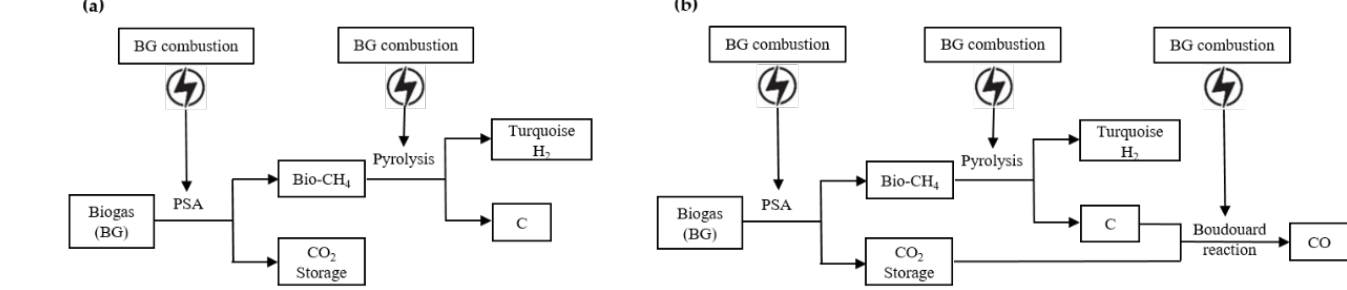
Figure 6. PFD of ( a ) turquoise hydrogen (BG-BG) and ( b ) turquoise hydrogen (BG-BG) with Boudouard reaction.